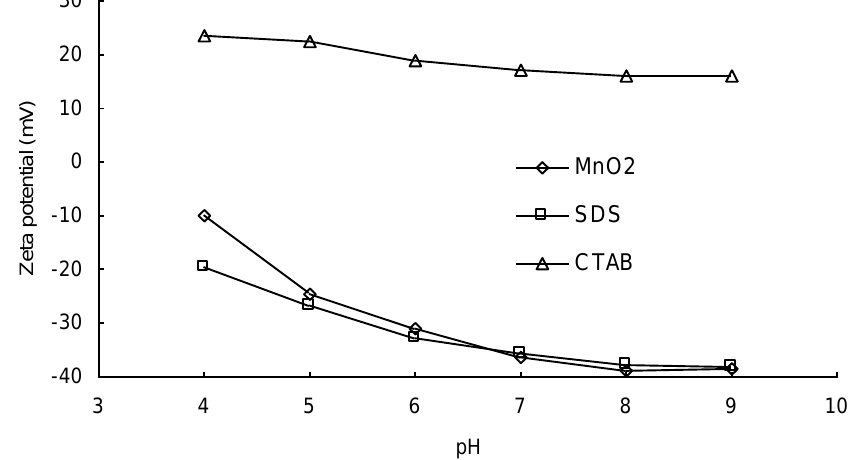
Figure 2. Variations in the zeta potential on the manganese oxide powder surface at different pH values and effects of the addition of different kinds of surfactant.